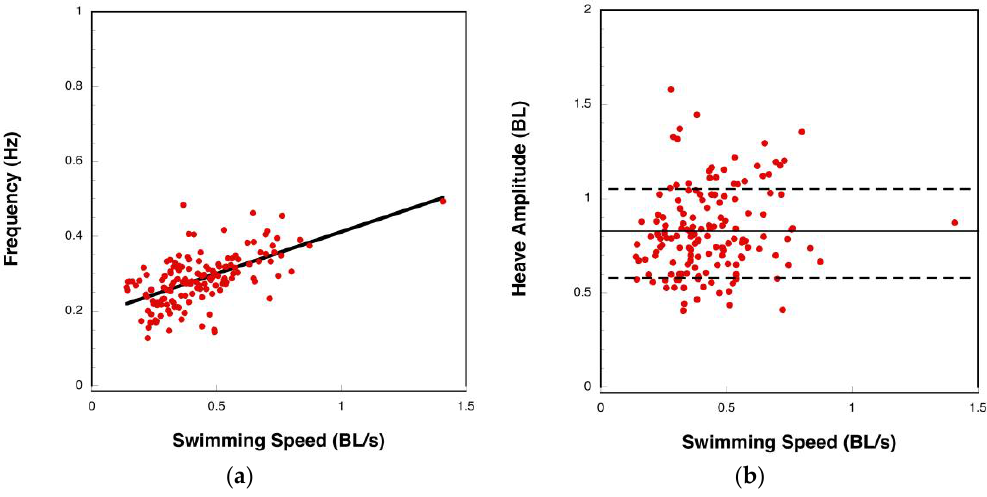
Figure 9. Relationships of pectoral fin oscillatory kinematics (frequency, heave amplitude) with swimming speed for all mantas measured. ( a ) Frequency increased with increasing swimming speed. The black line shows the regression for the data; ( b ) Heave amplitude remained constant over the range of swimming speeds. The solid black line indicates the mean heave amplitude and the black dashed lines show the mean heave amplitude ± one standard deviation.